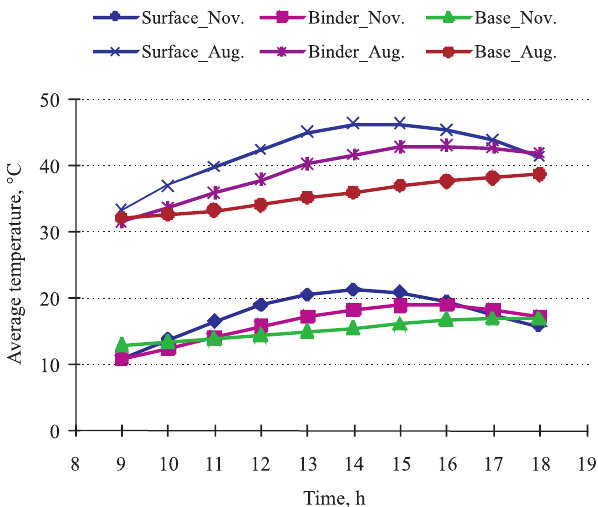
Fig. 5. Average measured temperature in August and November,